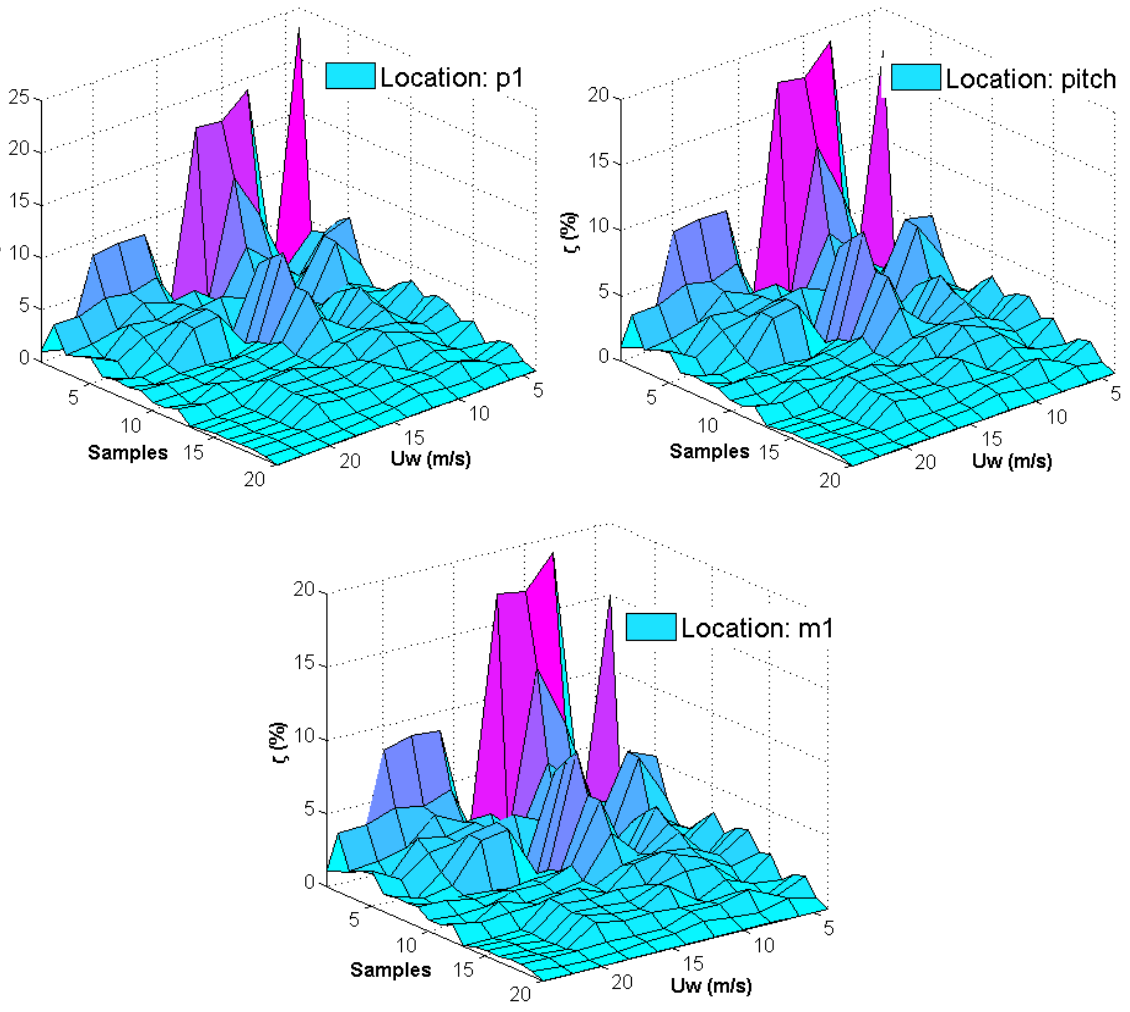
Figure 17. Variation of ζ [Equation (2)] when using the 4P controller at different contact points, wind speeds and number of simulation